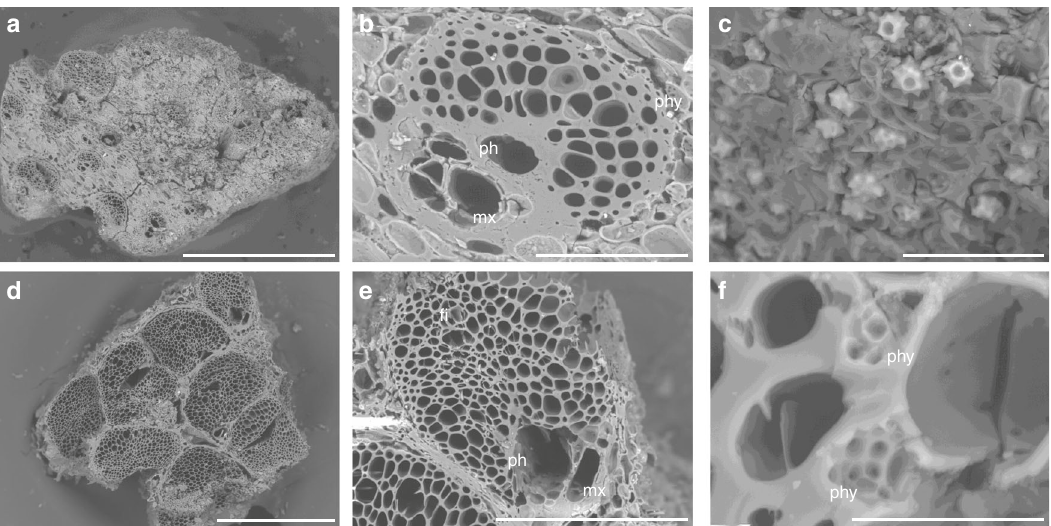
Fig. 4 Examples of Arecaeae family stem tissue from Phase 2. a – c Transverse section of Arecaceae stem Type A (cf. Livistona spp.) from C2/44, a scale bar is 1 mm, b close-up of fi brovascular bundle, scale bar is 100 µ m, c close-up of globular echinate phytoliths, scale bar is 30 µ m; d , f transverse section of Arecaceae stem Type B from C2/44, d scale bar is 500 µ m, e close-up of fi brovascular bundle, scale bar is 200 µ m; f transverse section of Arecaceae stem Type B from C2/45, close-up of globular echinate phytoliths, scale bar is 20 µ m. See the supporting online information and Supplementary Fig. 8 for a detailed identi fi cation proof of Arecaceae stem Type A (cf. Livistona spp.) and the corresponding reference material. ph phloem, mx metaxylem, phy